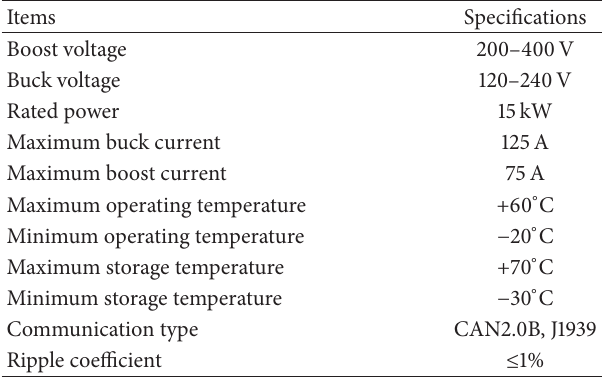
Table 3: Parameters of the DC/DC